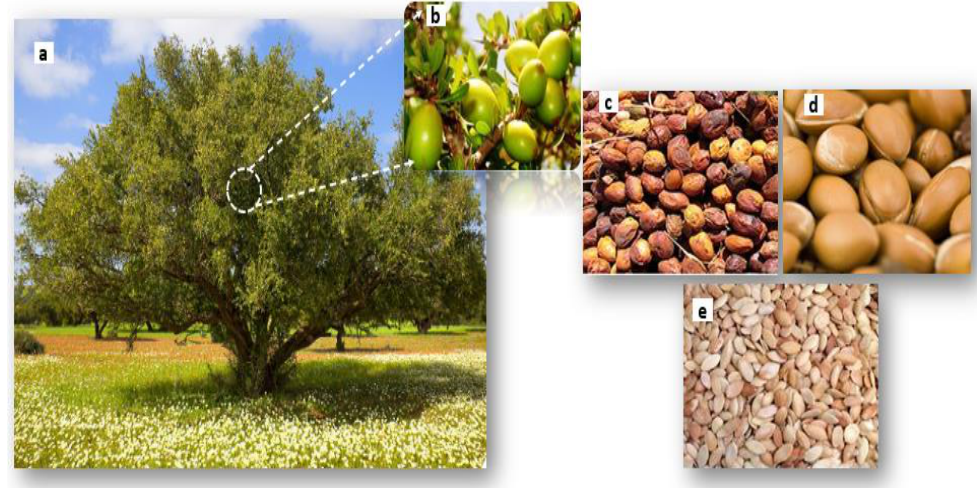
Figure 1. The argan tree (Argania spinosa (L) Skeels) and its different parts: ( a ) tree, ( b ) immature fruits, ( c ) pulp, ( d ) shell, ( e ) kernels.